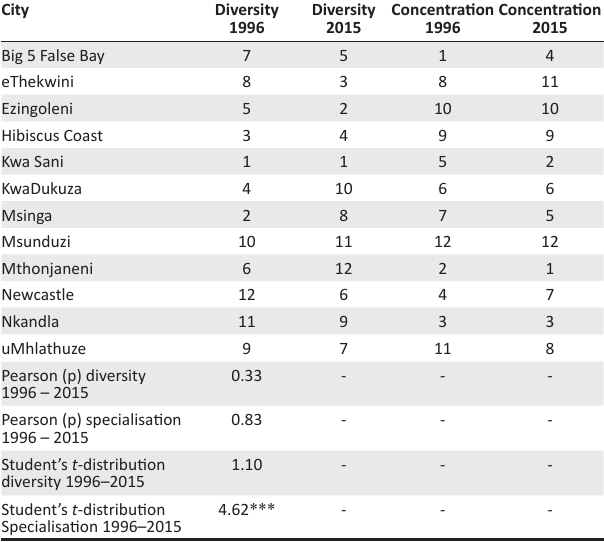
TABLE 8: Diversity relation and city specialisation relation of KwaZulu-Natal cities. City